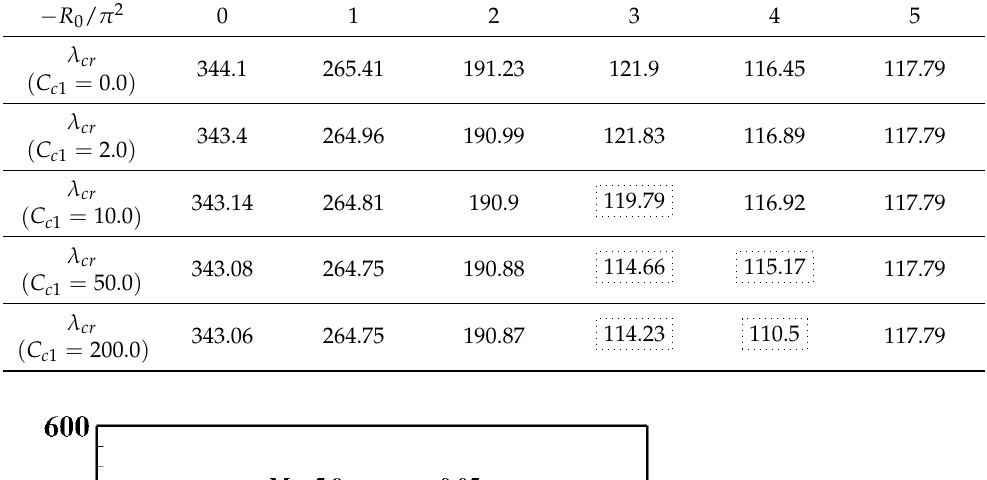
Table 2. The critical dynamic pressure when bifurcation occurs under different inertial resistances.